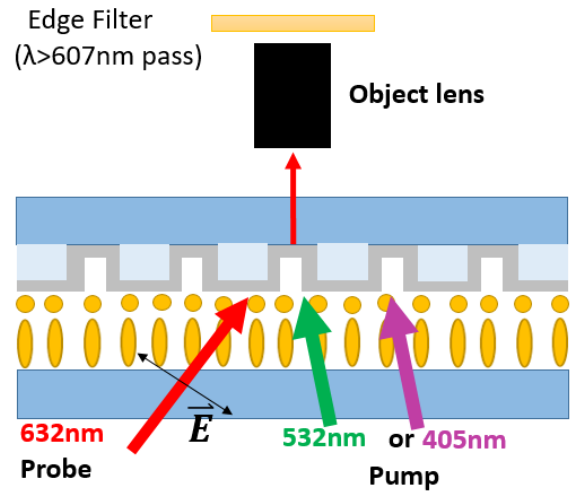
Figure 2. Setup of optical microscope. The pump and probe light were incident to the side of the cell and the signal transmission through the Al was collected by the microscope. The LC alignment is in HAN